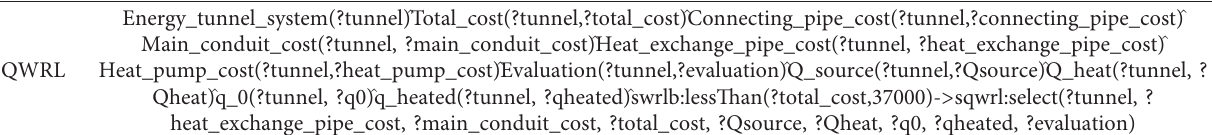
Table 8: SQWRL rule for selecting design schemes with cost below CNY 37000.